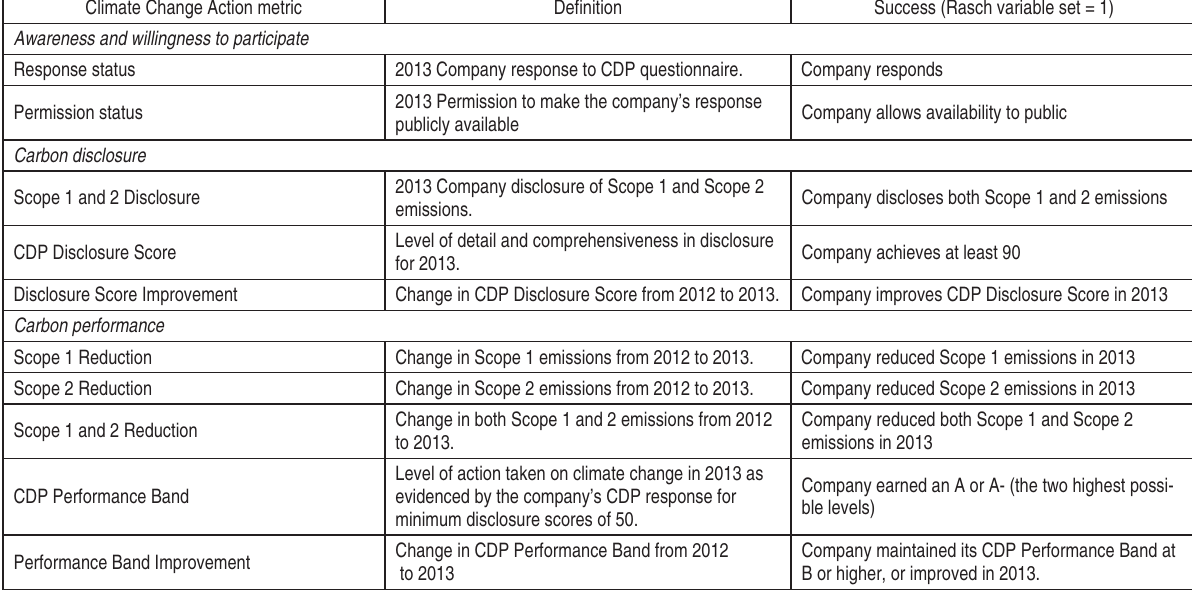
Table 1. “CDP” and capitalization should be consistentDefinition of Climate Change Action metrics “CDP” sample of 32 U.S. financial firms 2013